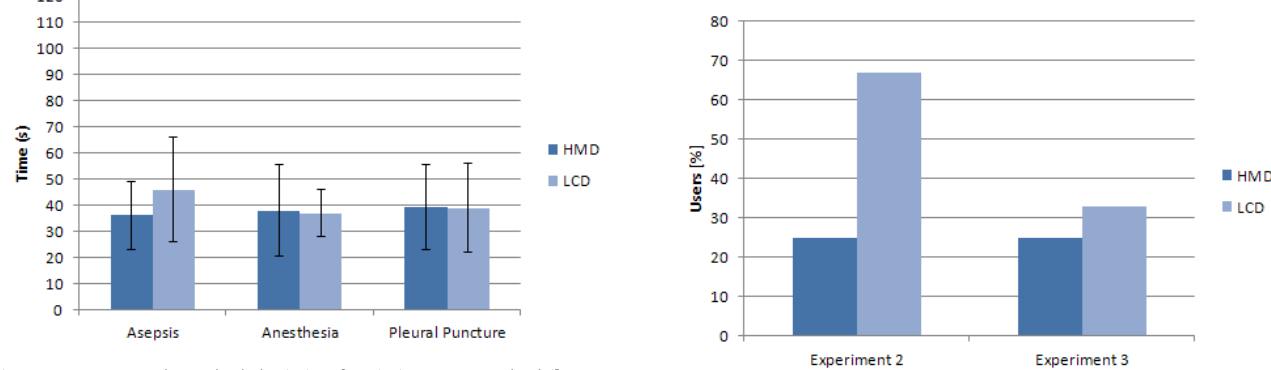
Fig. 19. Averages and standard deviation for timings measured while users perform the actions related to the thoracocentesis procedure.